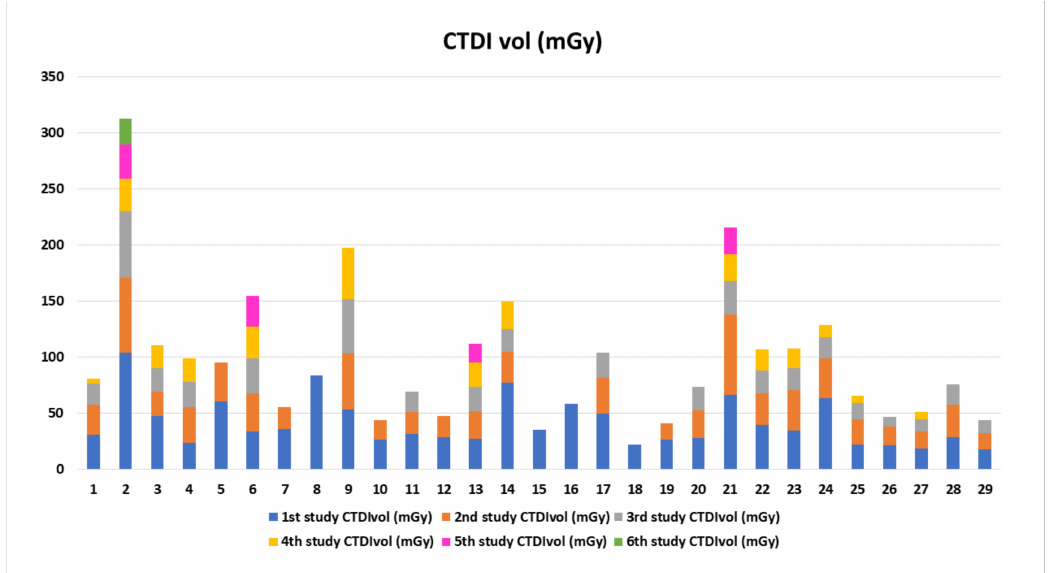
Figure 4. The cumulative computed tomography dose index volume (CTDI vol ) for each